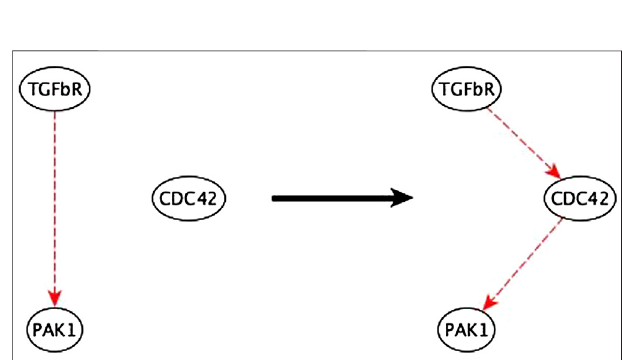
FIGURE8| Exampleofaninputperturbation whereanindirectregulator has the same logic implication re fl ected by a path formed by direct regulators. TCF/LEF is a suf fi cient indirect regulator of SNAI1 and a suf fi cient direct regulator of GLI which is a suf fi cient direct regulator ofSNAI1. Hence the suf fi cient indirect edge from TCF/LEF to SNAI1 is re fl ected in the suf fi cient path TCF/LEF → GLI → SNAI1.